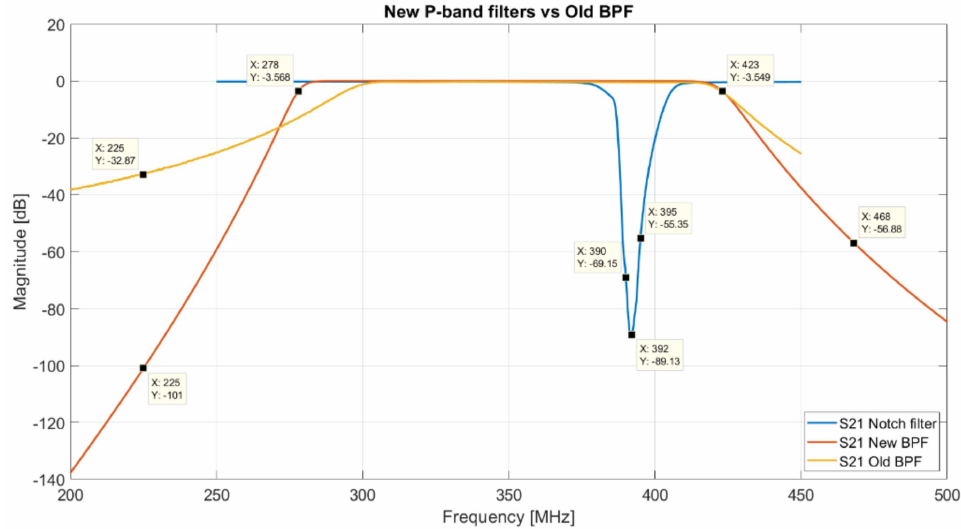
Figure 14. Comparison between the S21 parameter of the old P-band BPF (orange curve), centered at 357.5 MHz with a bandwidth of about 120 MHz (model 5B340-357.5/T120-O/O from K&L) and the new ideal filters (Notch filter and new BPF). The Notch filter (blue curve) rejects the bandwidth 385–395 MHz (TETRA signals of Figure 9) and the new BPF (red curve) has a − 3 dB frequency response between 280 and 420